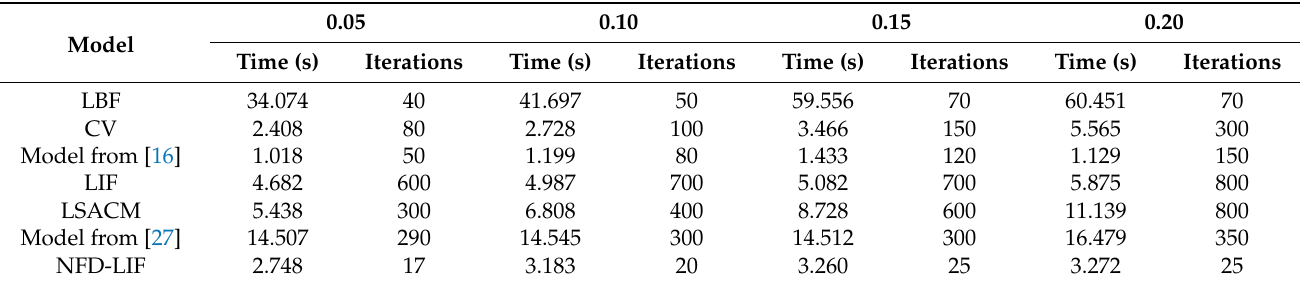
Table 3. Comparison of Model Segmentation Running Times and Number of Iterations for Different Pretzel Noise Levels on Structurally Information-Rich Images.